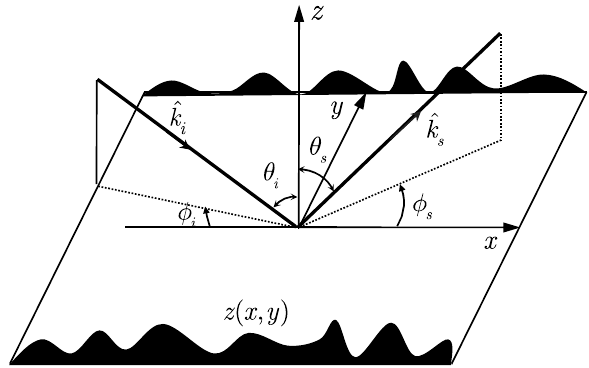
Figure 1. Geometry of bistatic radar scattering from a rough surface.